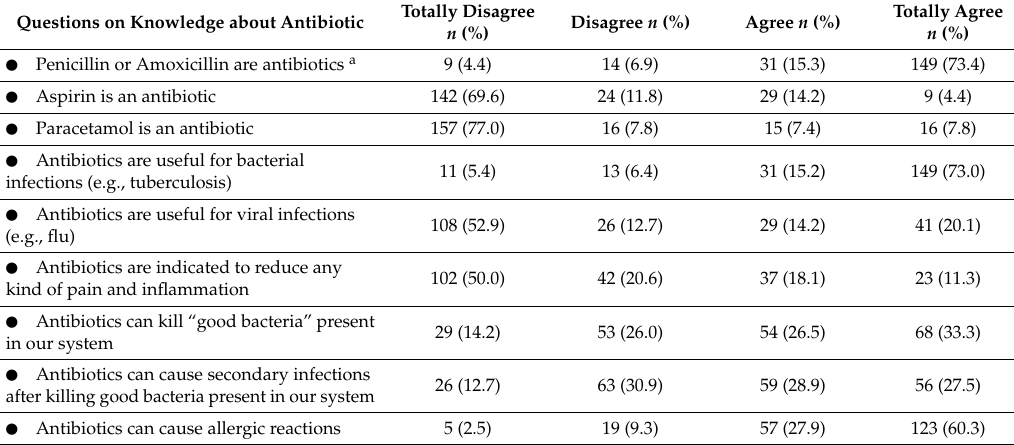
Table 2. Knowledge about antibiotics ( n =